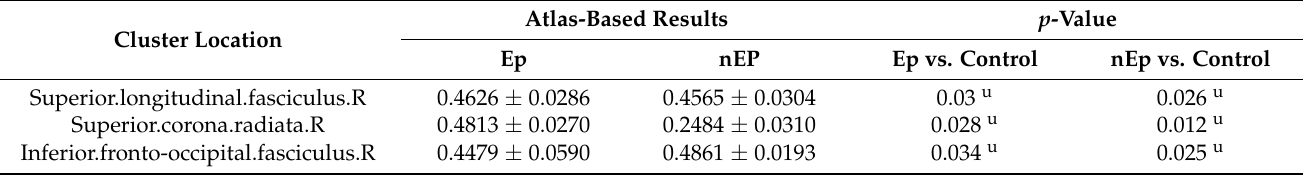
Table 3. Atlas-based